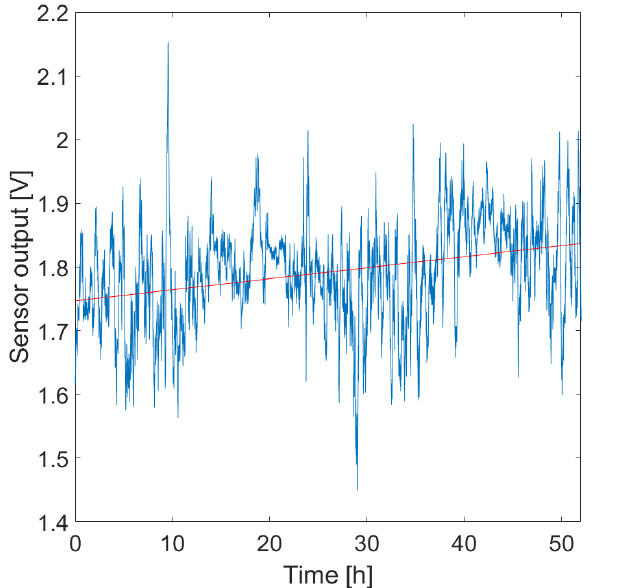
Figure 12. Sensor’s output plotted over time (blue line), and 1st order polynomial fitting showing the growth trend (red line).